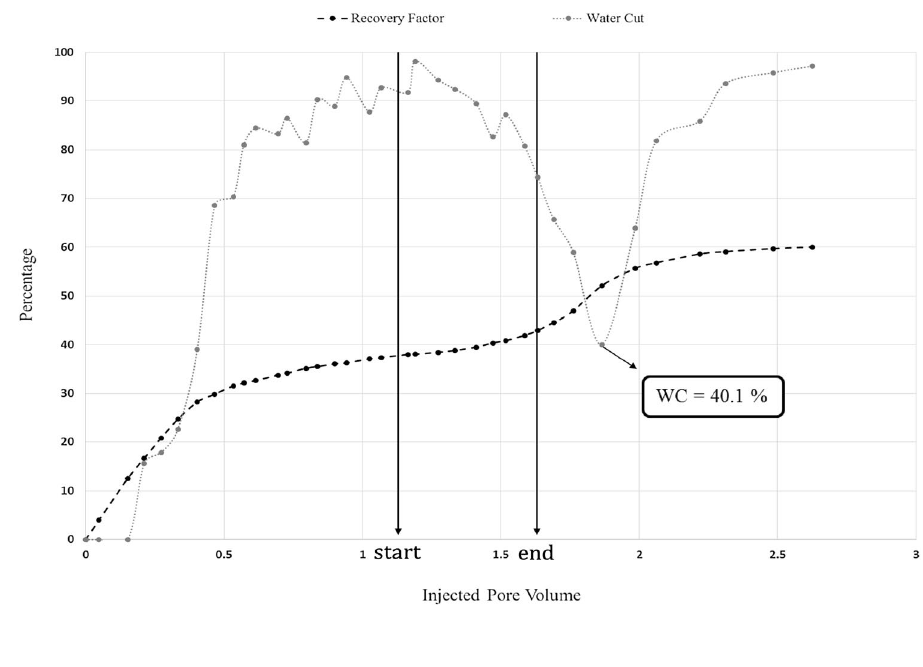
Fig. 9 Comparative potential of emulsions and SW for reducing water